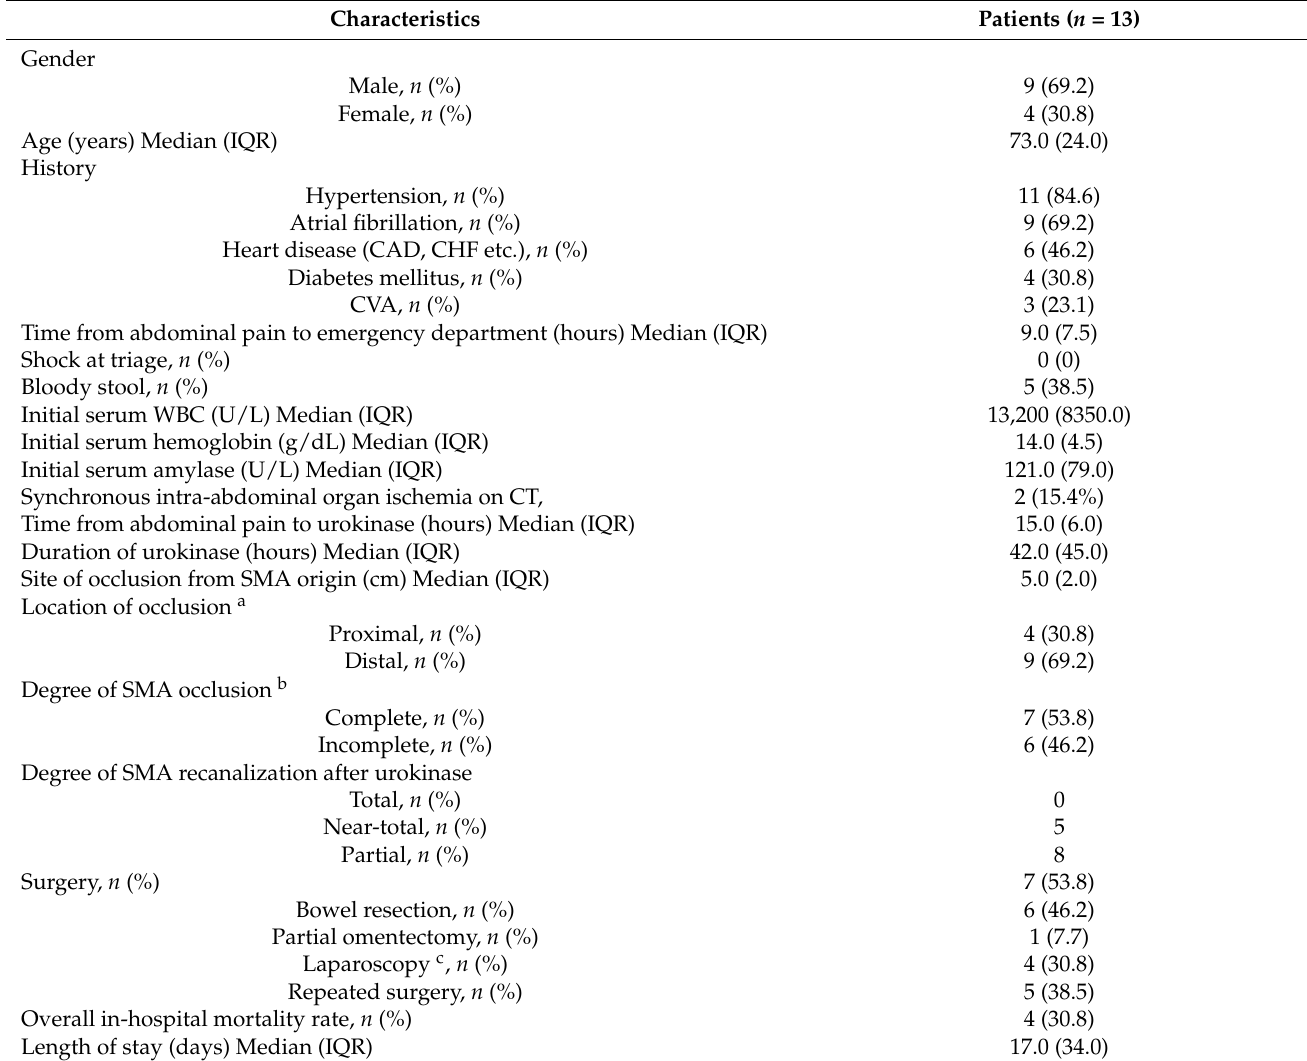
Table 1. Demographic data and clinical characteristics of the 13 patients with superior mesenteric artery (SMA)